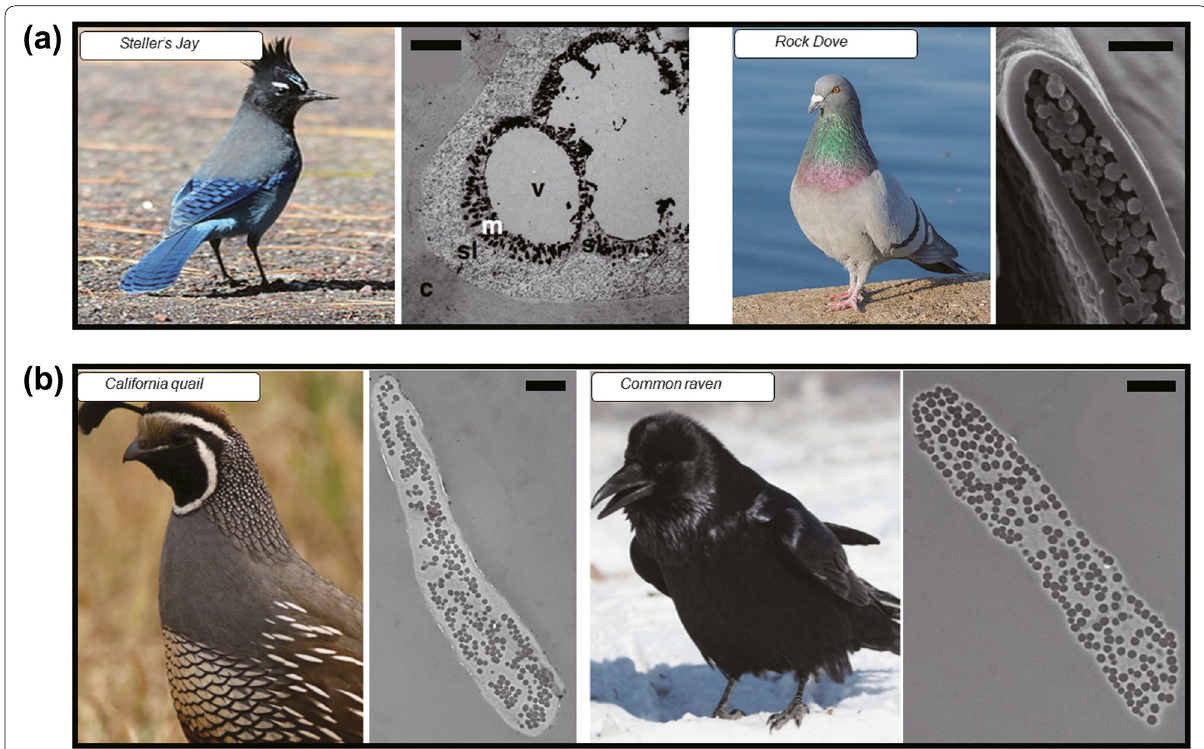
Fig. 4 Melanin as an absorbing material of broadband visible wavelengths for coloration. ( a ) Amorphous melanosomes in the blue barb of the Steller’s jay and the barbule of the rock dove’s (domestic pigeon) feathers. (Scale bars: 2 μm). Steller’s Jay, image reproduced under CC